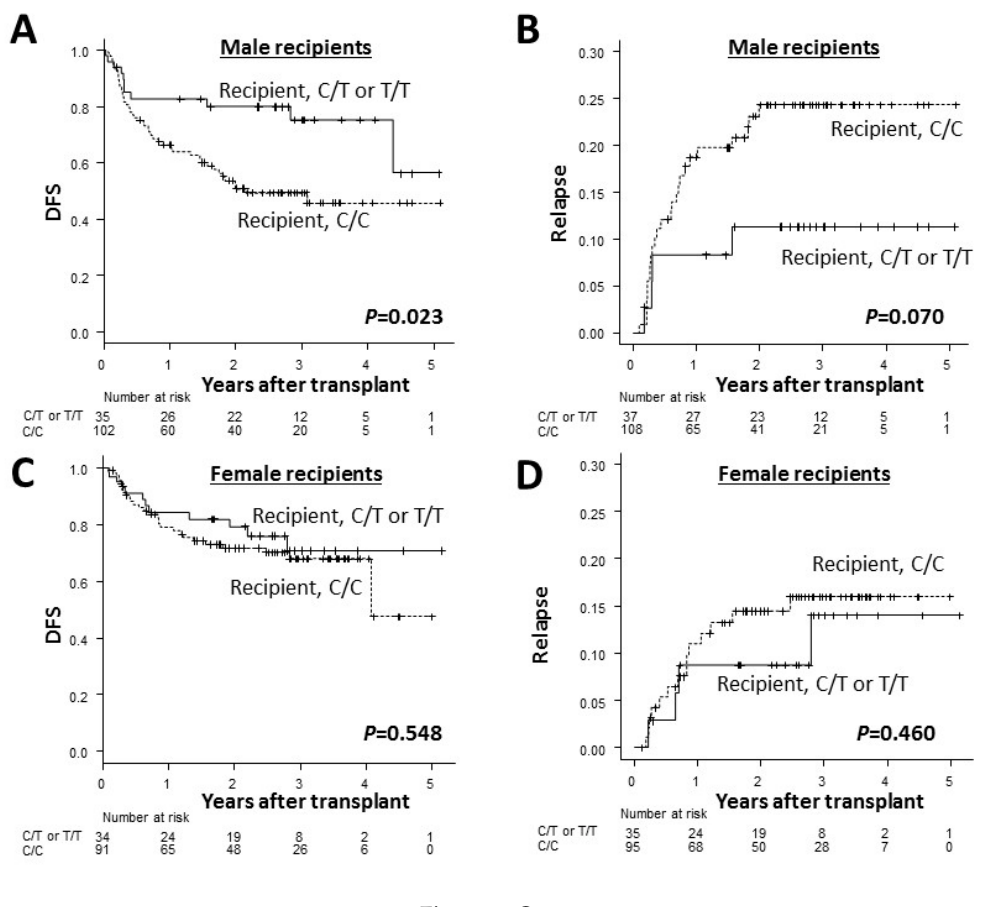
Figure 3. Cont. Figure 3.